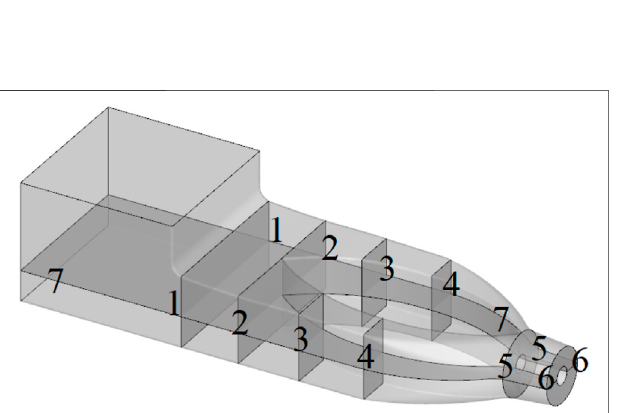
FIGURE 7 | Location of the analysis cross section.